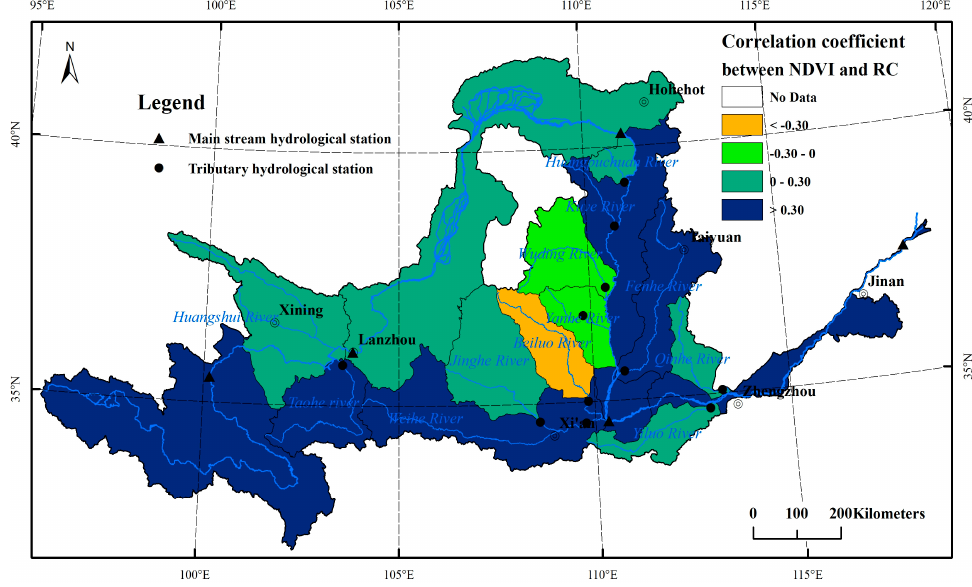
Figure 10. Correlation coefficients between NDVI and the runoff coefficient in the Yellow River basin.